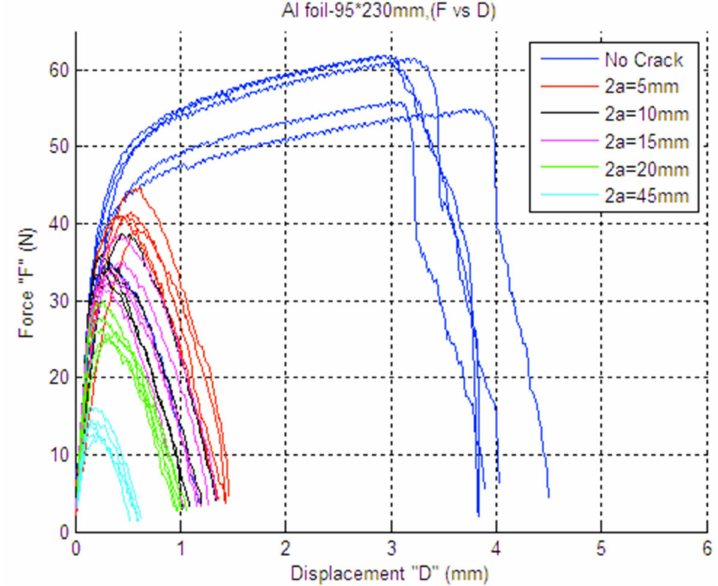
Figure 6. Load vs. displacement of Al-foil (center cracked) of 0–45 mm for all